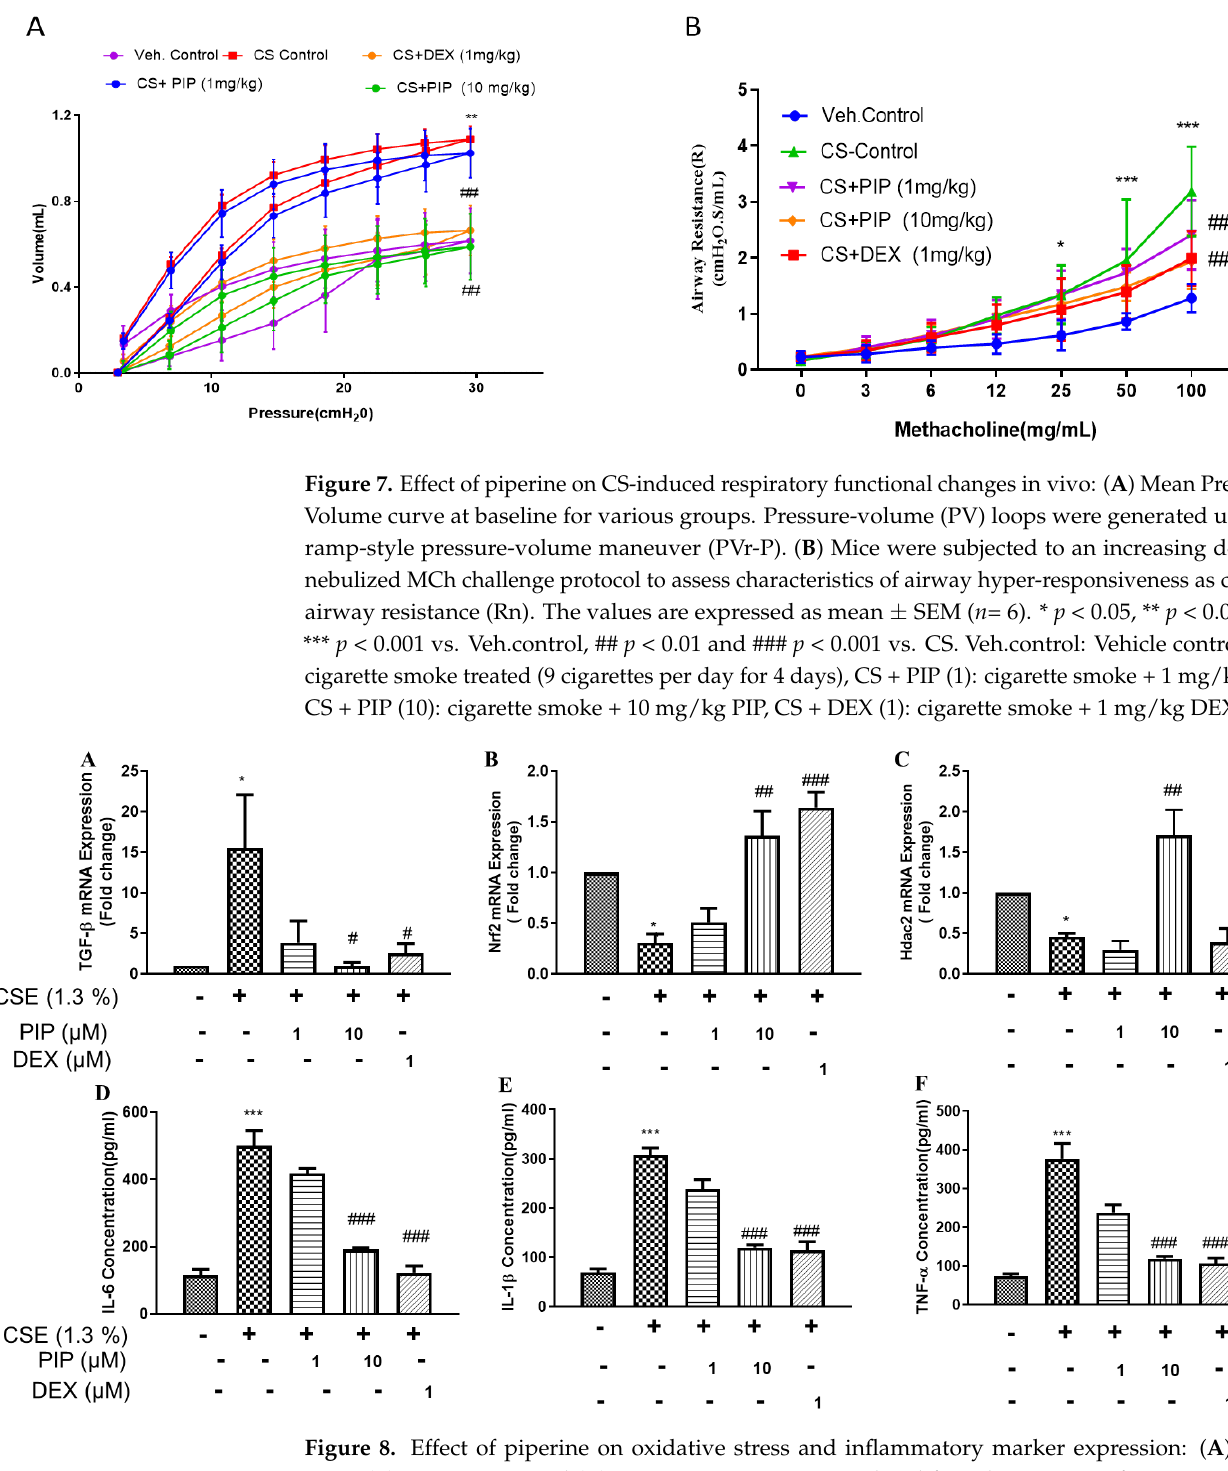
Figure 8. Effect of piperine on oxidative stress and inflammatory marker expression: ( A ) Nrf2 gene, ( B ) TGF- β gene and ( C ) HDAC2 gene in RNA isolated from lung tissue of various groups. Inflammatory markers estimated in BAL fluid of various groups- ( D ) IL-6 expression, ( E ) IL-1 β expression and ( F ) TNF- α expression. The values are expressed as mean ± SEM ( n = 3–6). * p < 0.05, *** p < 0.001 vs. Veh.Control, # p < 0.05, ## p < 0.01 and ### p < 0.001 vs. CS. Veh.Control: Vehicle control, CS: cigarette smoke treated (9 cigarettes per day for 4 days), CS + PIP (1): cigarette smoke + 1 mg/kg PIP, CS + PIP (10): cigarette smoke + 10 mg/kg PIP, CS + DEX (1): cigarette smoke + 1 mg/kg DEX.